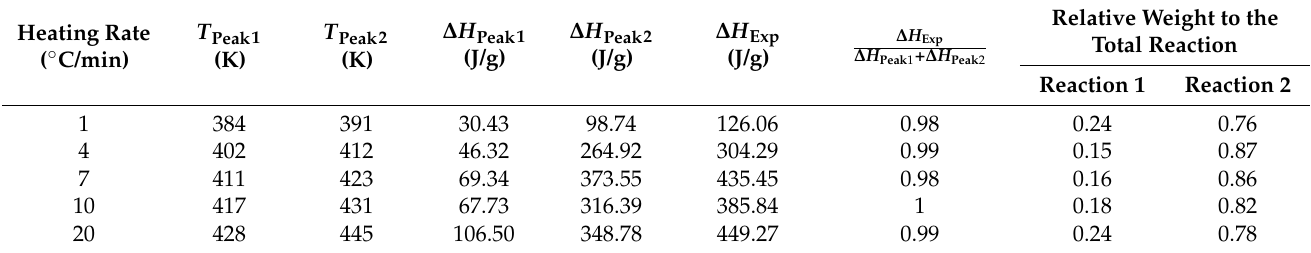
Table 1. Peak positions and enthalpies for deconvoluted DSC